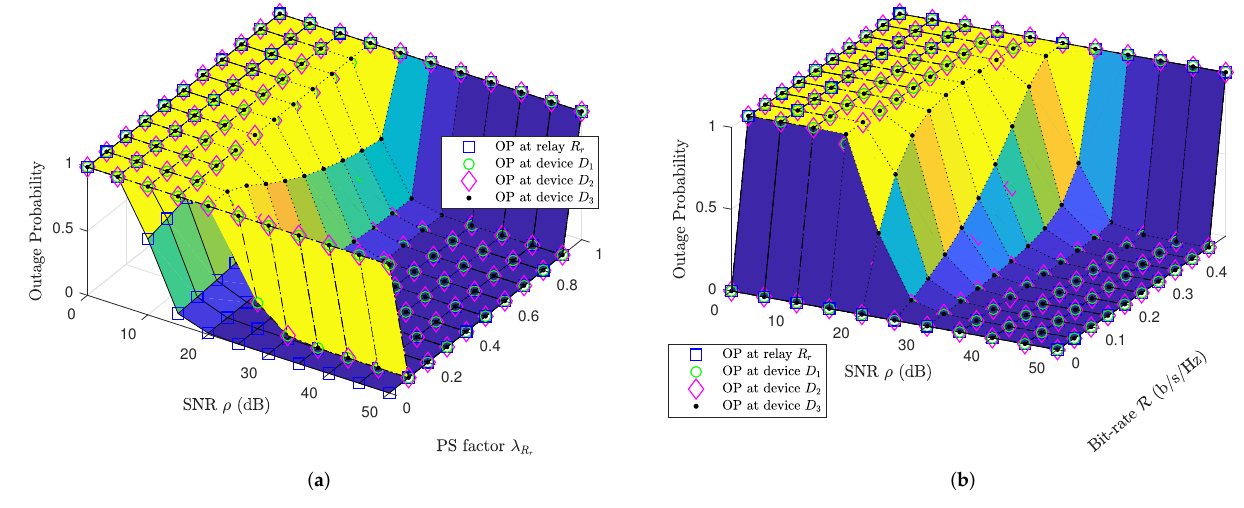
Figure 3. Comparisons of OP at coupled IoT relay R r and IoT devices with ( a ) fixed pre-defined bit-rate threshold R = 0.1 b/s/Hz versus PS factors λ R = 0.4 versus pre-defined bit-rate threshold R = { 0, . . . ,0.5 } b/s/Hz. λ R r Figure 4a presented OP performance at coupled IoT relays and IoT devices, where fixed pre-defined bit-rate threshold R = 0.1 b/s/Hz and PS factor λ R The OP performance of IoT devices are approximate and tend to zero when SNR ρ → ∞ .